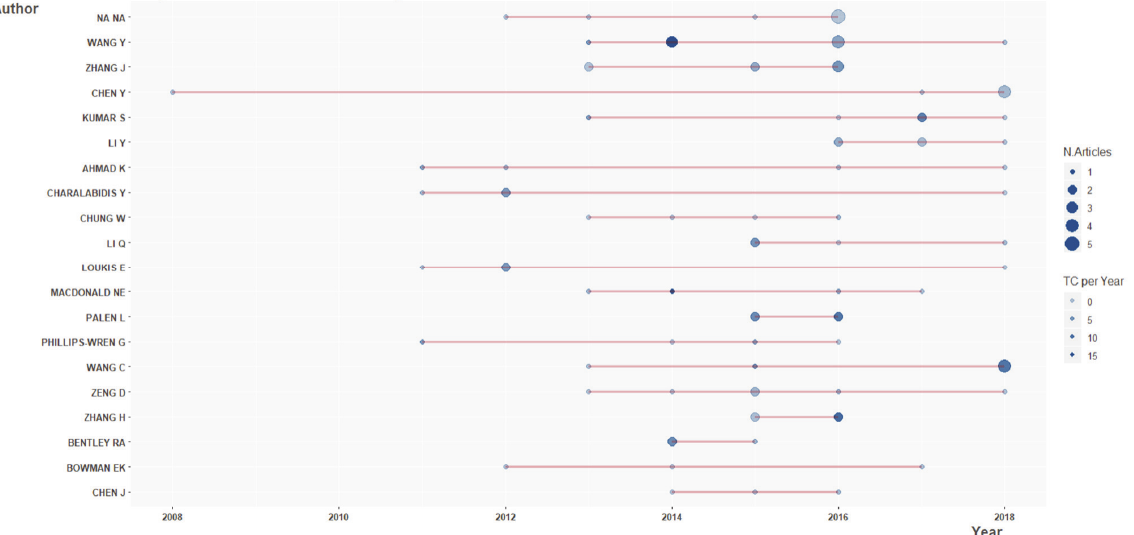
Fig. 4. Top-Authors’ productivity over the time